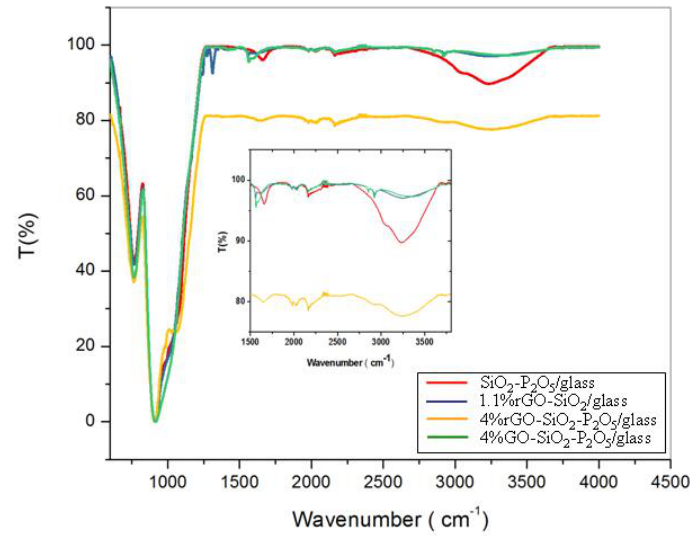
Figure 3. The FTIR spectra of the deposited reduced graphene oxide (rGO)- / GO-containing thin films. Table 2. Summary of absorption bands in the FTIR spectra of the investigated